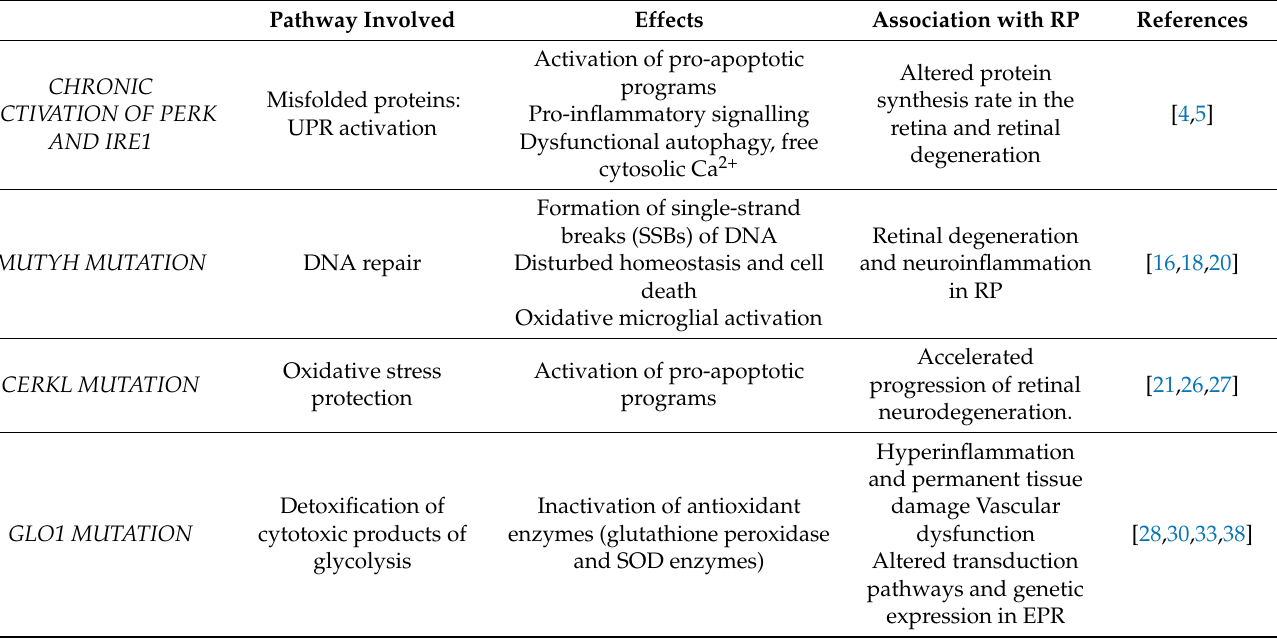
Table 1. Altered pathway involved in endogenous antioxidant defence and their effects on retinal tissue. Pathway